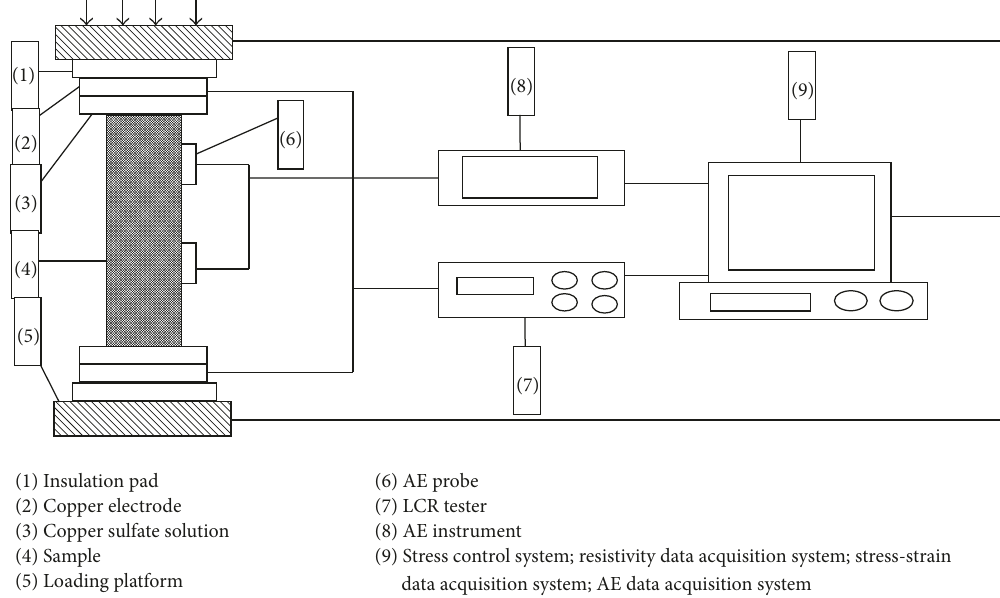
Figure 1: Stress-strain-resistivity testing device diagram.